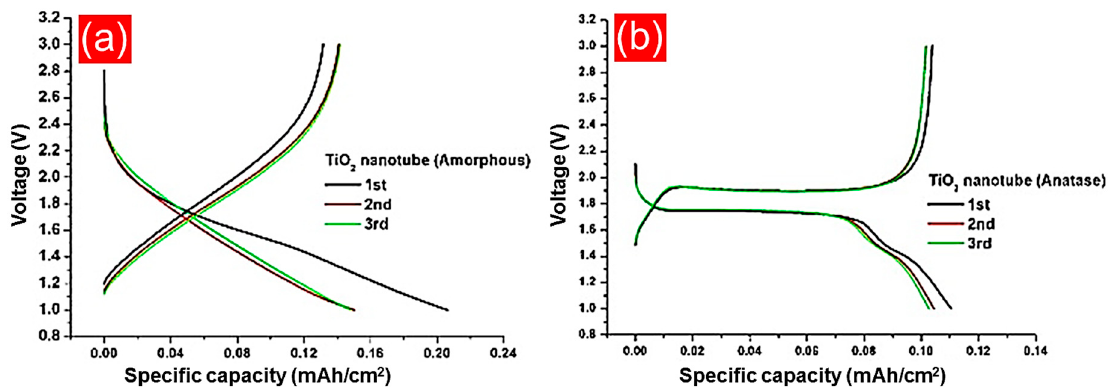
Figure 11. Voltage profiles of ( a ) amorphous TiO 2 and ( b ) anatase nanotubes measured at a current density of 100 µA cm − 2 . Adapted with permission from ref. [150].